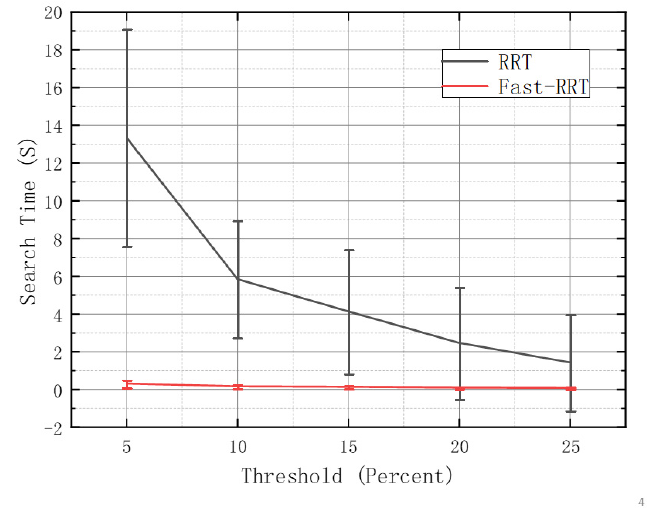
Figure 15. Comparison of the time required for Fast-RRT and RRT* algorithms to find an approximate optimal path when the gap between the approximate optimal path and the theoretical optimal path is different thresholds. It can be seen that compared with the RRT* algorithm, the Fast-RRT algorithm has an order of magnitude advantage in search time.